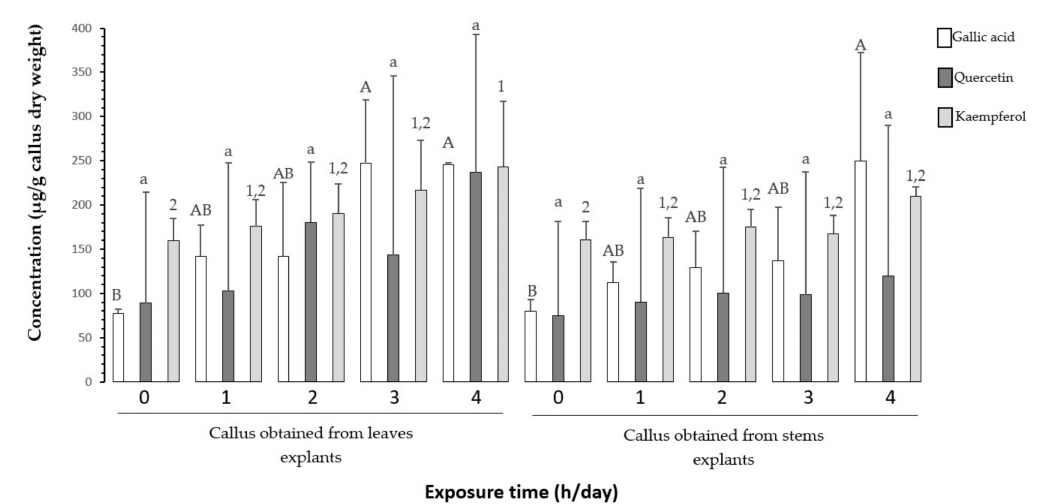
Figure 5. Effect of time of exposure to UV-B light on the concentration of gallic acid, quercetin